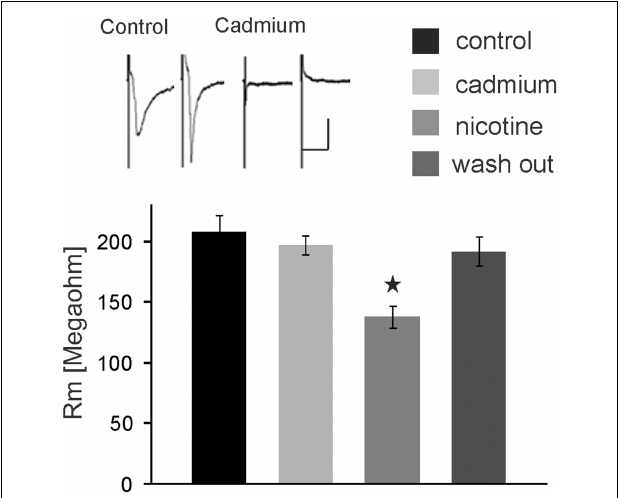
FIGURE 5 | The nicotine effect persists in presence of cadmium. Auditory and trigeminally evoked EPSCs were completely blocked by bath application of 100 μ M cadmium, see insert (horizontal bar indicates 25ms and vertical bar100 pA.) The effect of nicotine on the membrane resistance in PnC giant neurons persists in presence of 100 μ M cadmium, indicating that it does not require synaptic transmission. Asterisk marks statistical significance with p < 0 . 05 ( n = 9